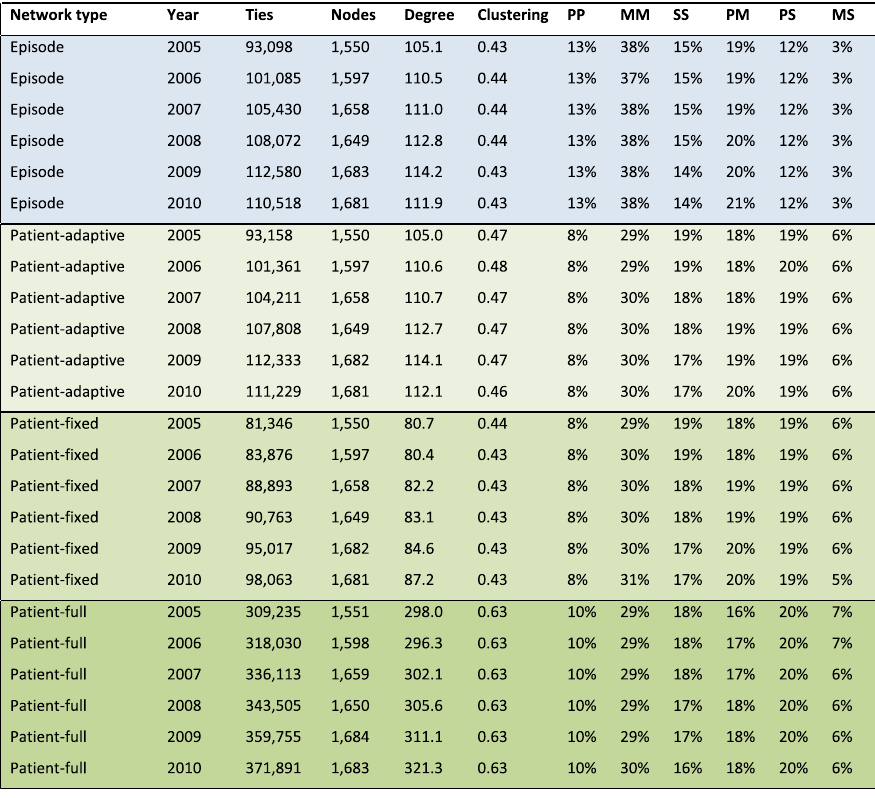
Table 1 Descriptive statistics for episode-based and patient-based networks from 2005 to 2010 constructed from 1-year windows. All statistics are averages over all HRRs. We report the average number of ties (Ties), average number of nodes (Nodes), average degree (Degree), average clustering (Clustering) and average proportion of tie types based on specialty (last six columns: PP, MM, SS, PM, PS, MS), where the specialties are primary care (P), medical specialist (M), and surgical specialist